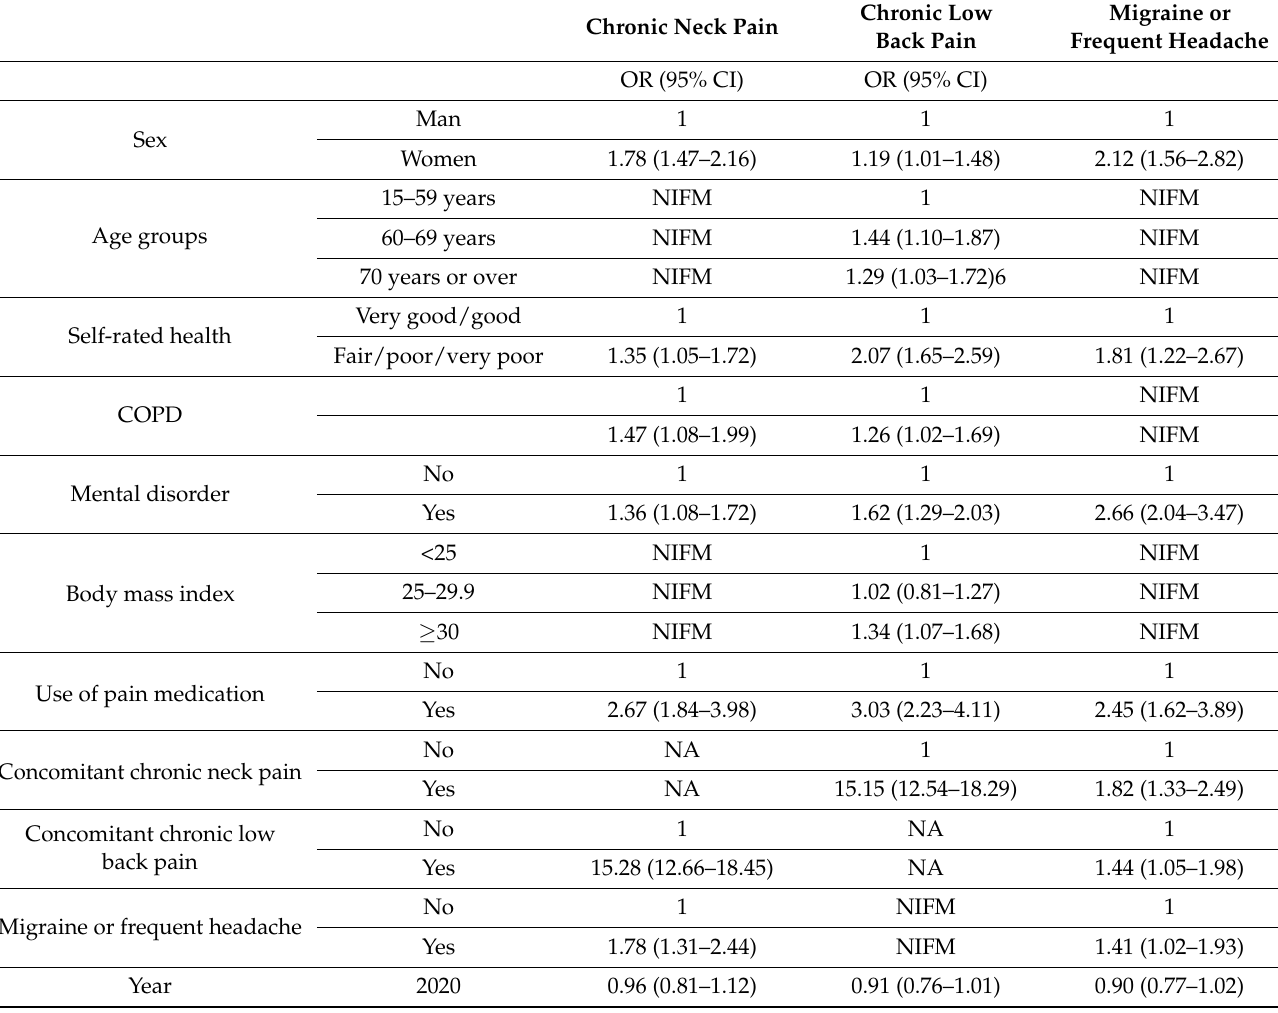
Table 4. Factors associated with suffering from chronic neck pain, chronic low back pain, and migraine or frequent headache among people with diabetes. Results of multivariable logistic regression